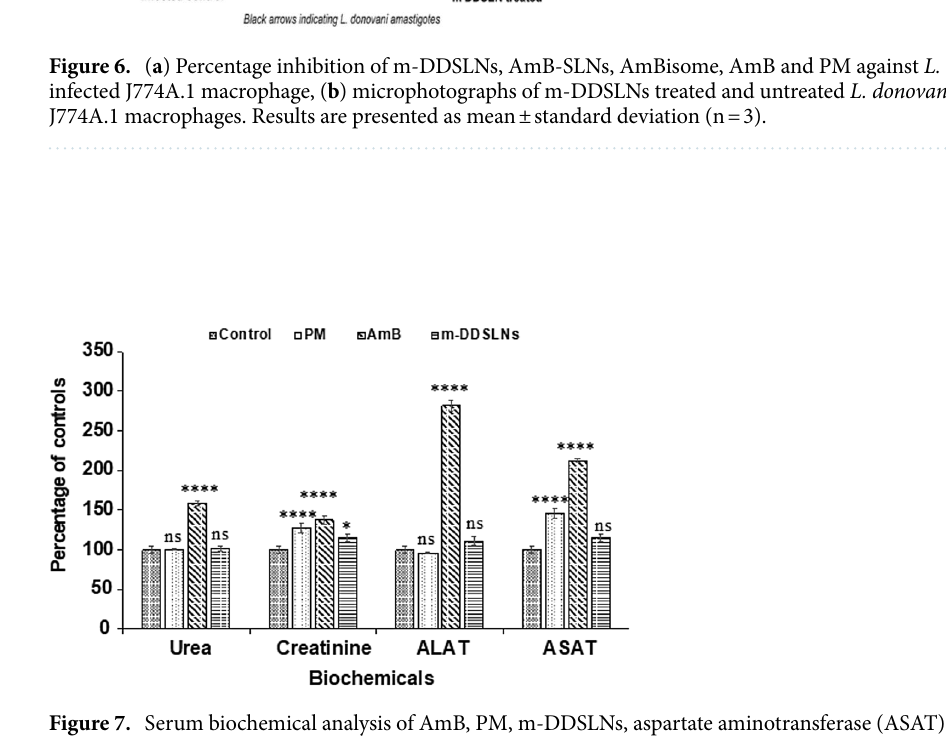
Figure 7. Serum biochemical analysis of AmB, PM, m-DDSLNs, aspartate aminotransferase (ASAT), alanine aminotransferase (ALAT), serum creatinine and blood urea for injection daily for 14 days (n = 3). Results are presented as the mean ± standard deviation (n = 3). Statistical significance was assessed using twoway ANOVA followed by Student’s t-test (**** P <